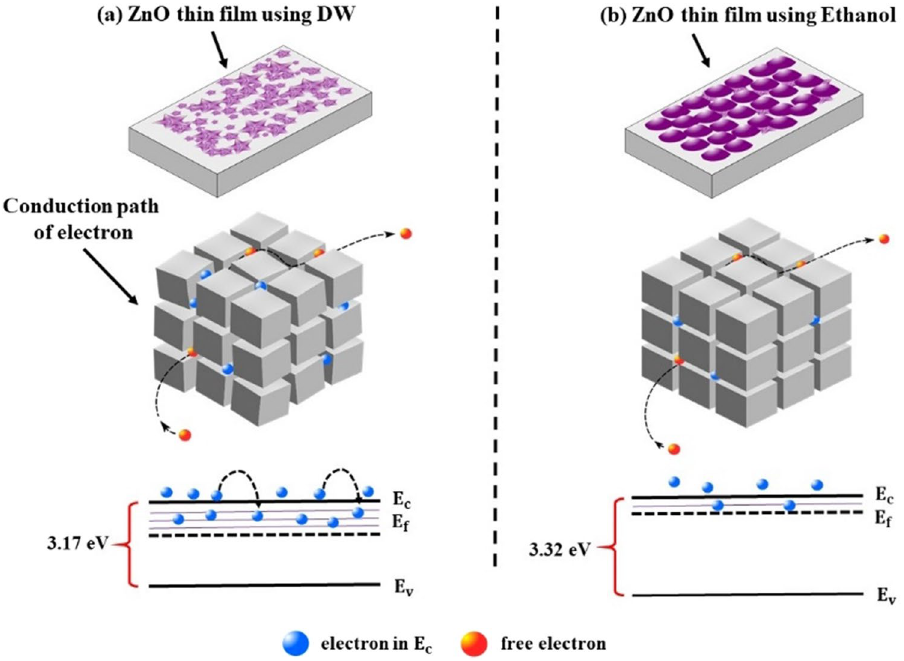
Figure 8. Illustration of conduction pathway of an electron at grains and grain boundary in ZnO films grown using ( a ) DW and ( b ) ethanol.